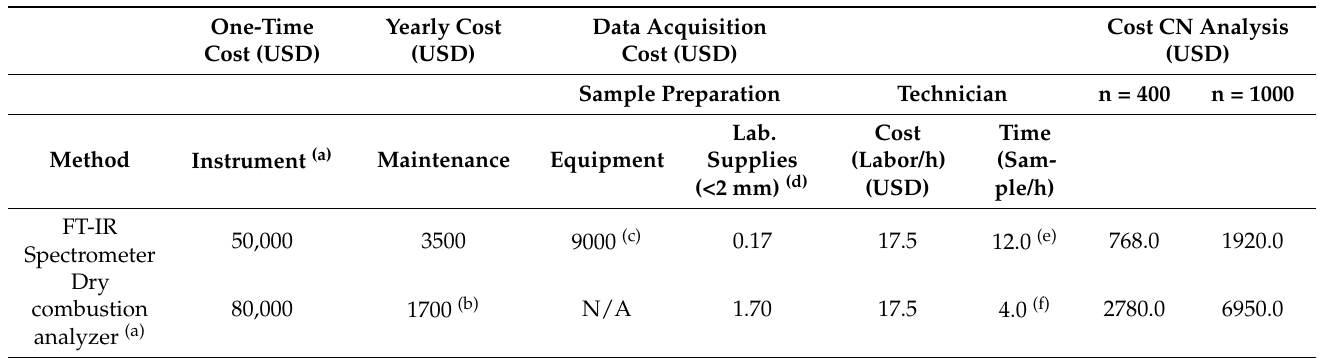
Table 3. Cost comparison analysis (USD) for measuring 400 and 1000 samples using FT-IR spectrom- eter and combustion